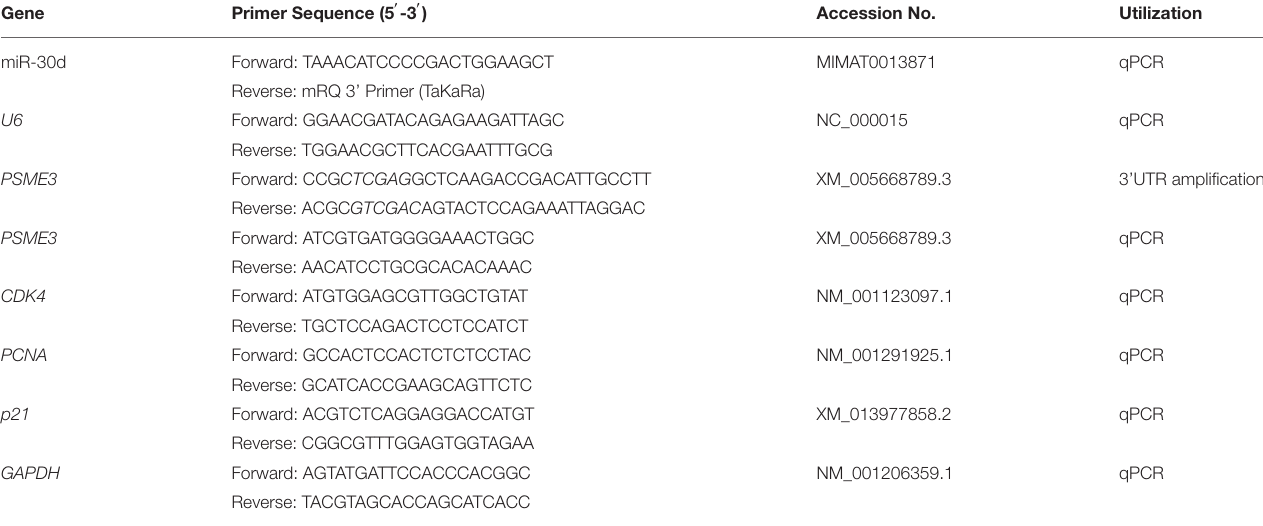
TABLE 1 | The primers used in this